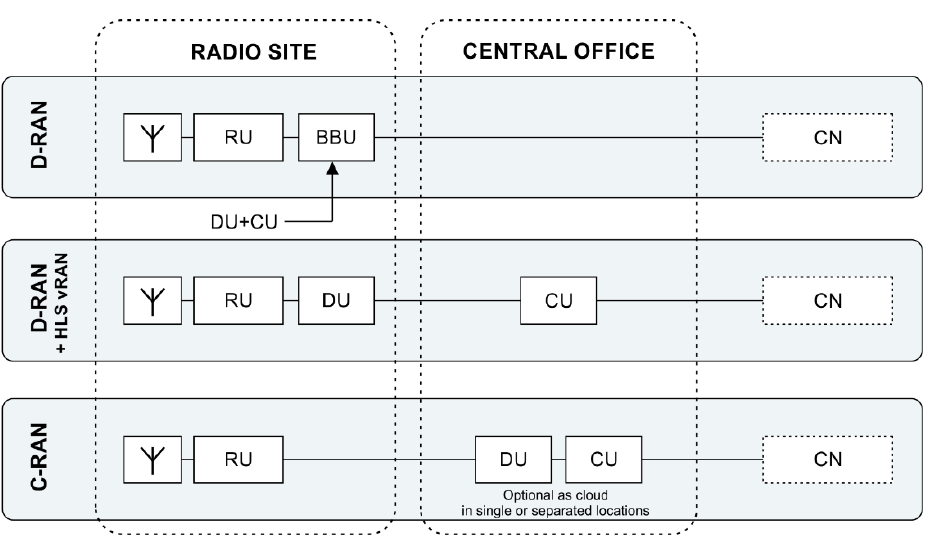
Figure 1. Difference between D-RAN, D-RAN partially cloudified and C-RAN. C-RAN does not define whether the 3GPP radio stack is running in Cloud (Cloud-RAN).